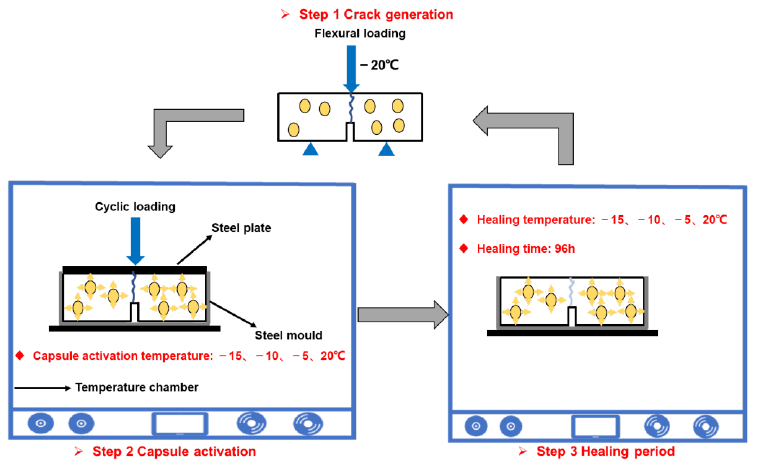
Figure 3. The fracture-healing-refracture test procedure for a bituminous concrete